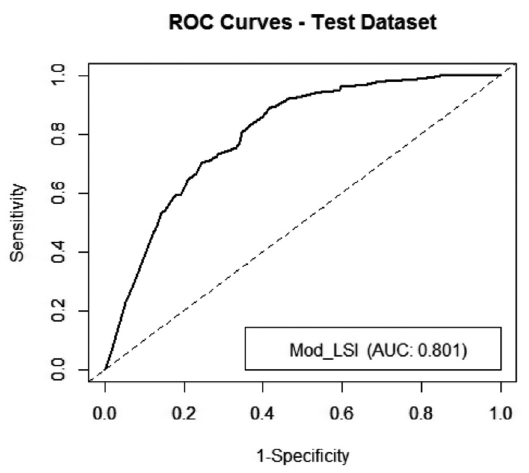
Figure 2. Accuracy assessment of landslide susceptibility model for the test